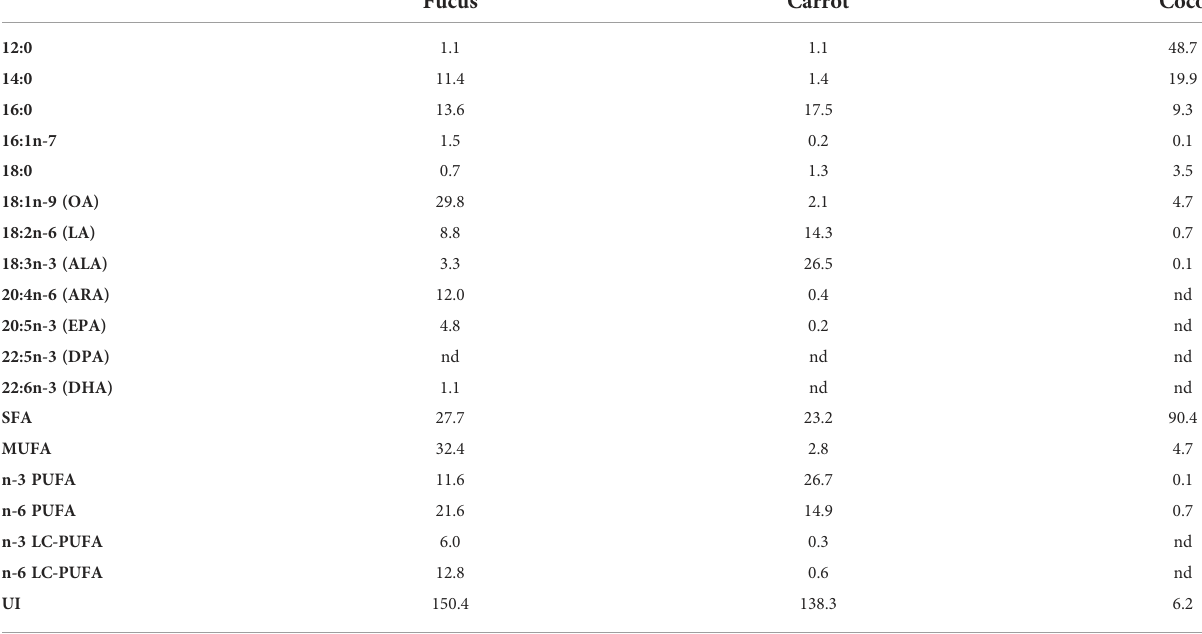
TABLE 2 Relative FA composition (% of total FA) of diets used in the feeding trial. Fucus Carrot